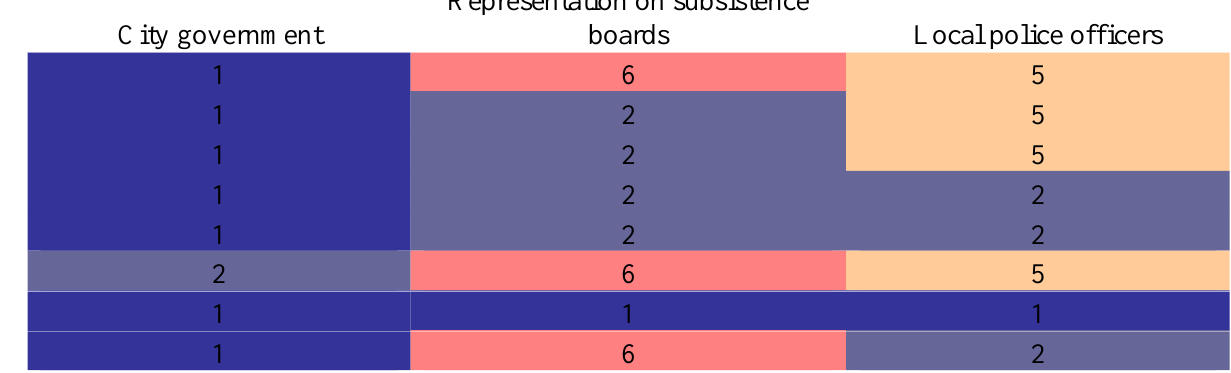
Table A2.14 Institutional capital –